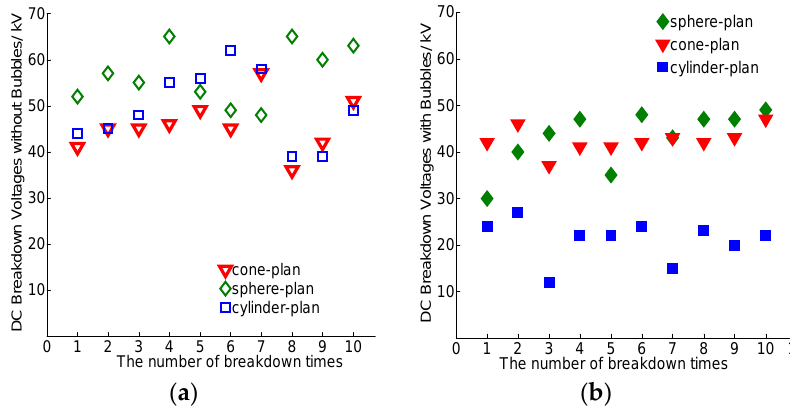
Figure 5. The positive DC breakdown voltages of the transformer oil. ( a ) The DC breakdown voltages of the oil without bubbles; ( b ) the DC breakdown voltages of the oil with bubbles.